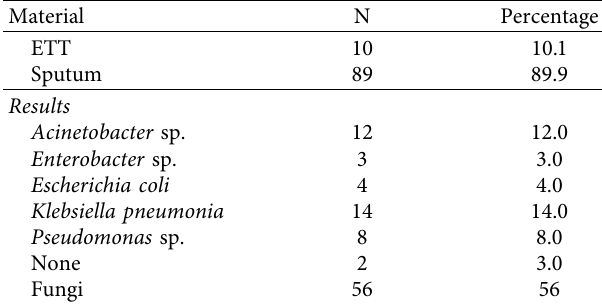
Table 1: Characteristics of hospitalized patients with